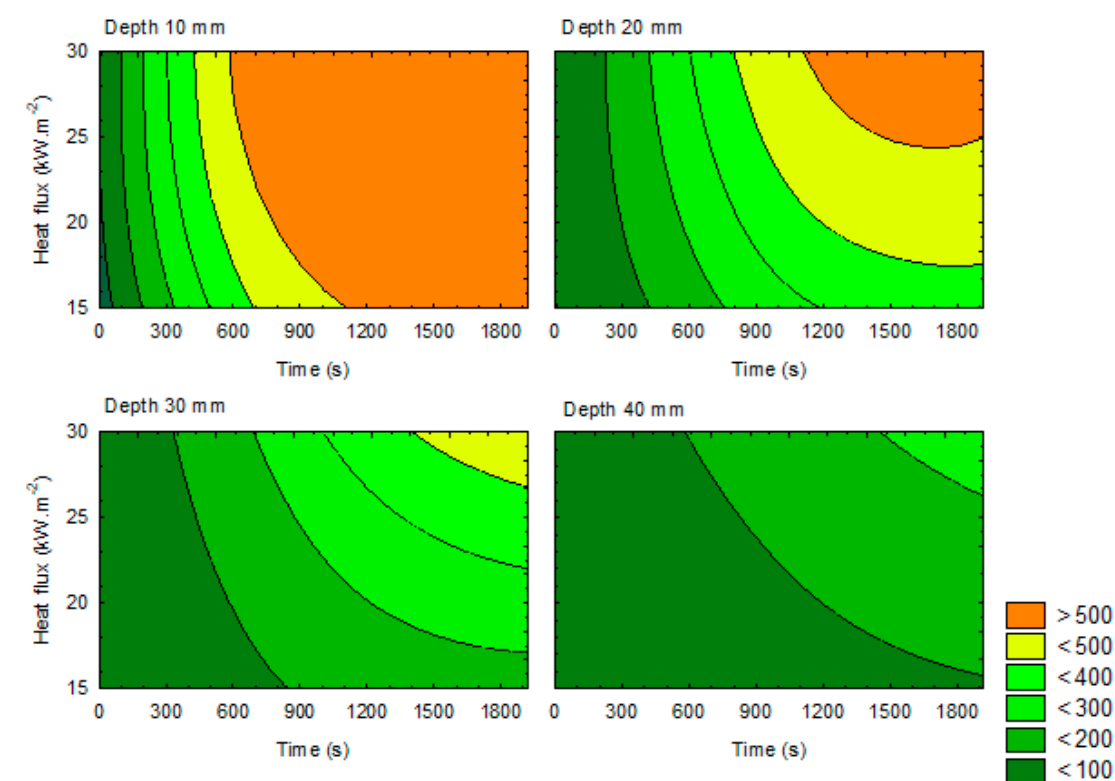
Figure 3. Model of the course of charred layer formation in time for respective depth. The marginal temperature needed to reach a charred layer is shown in light green. It is a temperature field reaching a temperature of 300 °C in the entire time interval (from 0 to 1920 s) of thermal loading with a ceramic infrared heater. The course of charred layer formation up to a depth of 10 mm under the surface is shown upper left. The rate and extend of charred layer formation clearly indicates the dependance on the heat flux and time of loading. At a heat flux of 15 kW ∙ m − 2 , the charred layer starts to form in a time of 200 s from the beginning of the loading; at a heat flux of 20 kW ∙ m − 2 , it forms in a time of 120 s; at a heat flux of 25 kW ∙ m − 2 , it forms in a time of 100 s; and at a heat flux of 30 kW ∙ m − 2 , it forms in a time of 95 s. Based on the measurement of temperature courses in test samples on thermocouple T1, different times of reaching the critical temperature of 300 °C were recorded. The measurements show that, for charred layer formation up to a thickness of 10 mm under the surface, the critical heat flux at a thermal load of 15 kW ∙ m − 2 occurs in 505 s, at a thermal load of 20 kW ∙ m − 2 occurs in 395 s, at a thermal load of 25 kW ∙ m − 2 occurs in 300 s, and at a thermal load of 30 kW ∙ m − 2 occurs in 315 s, i.e., in initiation phase of the fire. The course of the charred layer formation at a depth from 10 to 20 mm under the surface of test samples is shown in Figure 3 (upper right). The rate and extend of the charred layer formation also indicates the dependance on the heat flux and time of loading. At a heat flux of 15 kW ∙ m − 2 , the charred layer starts to form in a time of 760 s from the beginning of loading, at a heat flux of 20 kW ∙ m − 2 in 550 s, at a heat flux of 25 kW ∙ m − 2 in 460 s, and at a heat flux of 30 kW ∙ m − 2 in 415 s. It means that, for the charred layer formation at a depth from 10 to 20 mm under the surface of the test sample, the critical heat flux is 30 kW ∙ m − 2 , reached in a time of 415 s, i.e., in the third quarter of initiation phase of the fire (up to 600 s from the beginning of loading). The course of the charred layer formation at a depth from 20 to 30 mm under the surface of test samples is shown in Figure 3 (bottom left). The rate and extent of the charred layer formation indicate the dependance on the heat flux and time of loading. At a heat flux of 15 kW ∙ m − 2 , the charred layer was not formed within